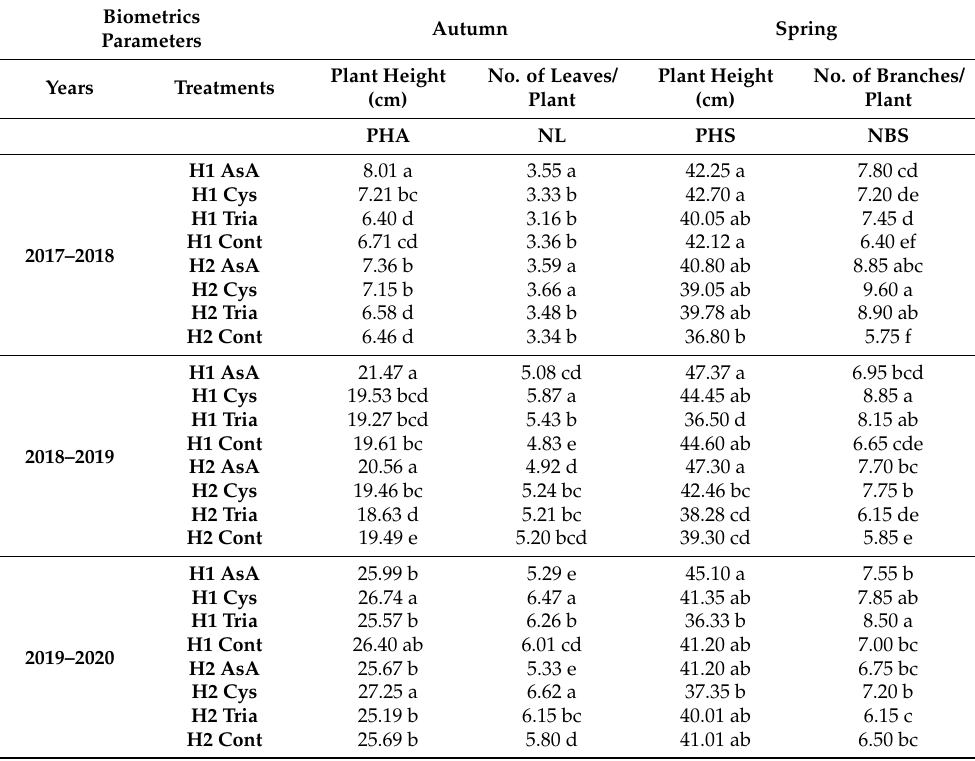
Table 7. Effects of seed priming and foliar treatment with bioactive substances on biometrics parame- ters of canola cultivars in autumn and spring (between the years